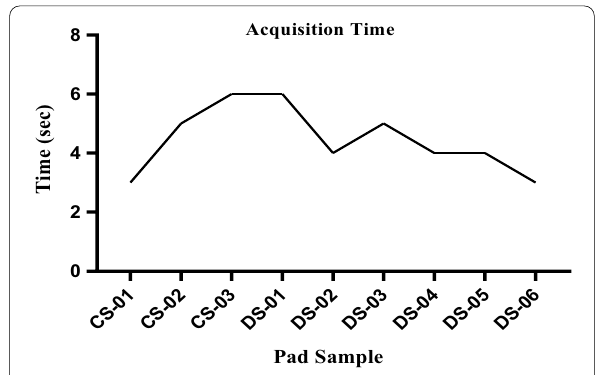
Fig. 9 Strike through test of various samples